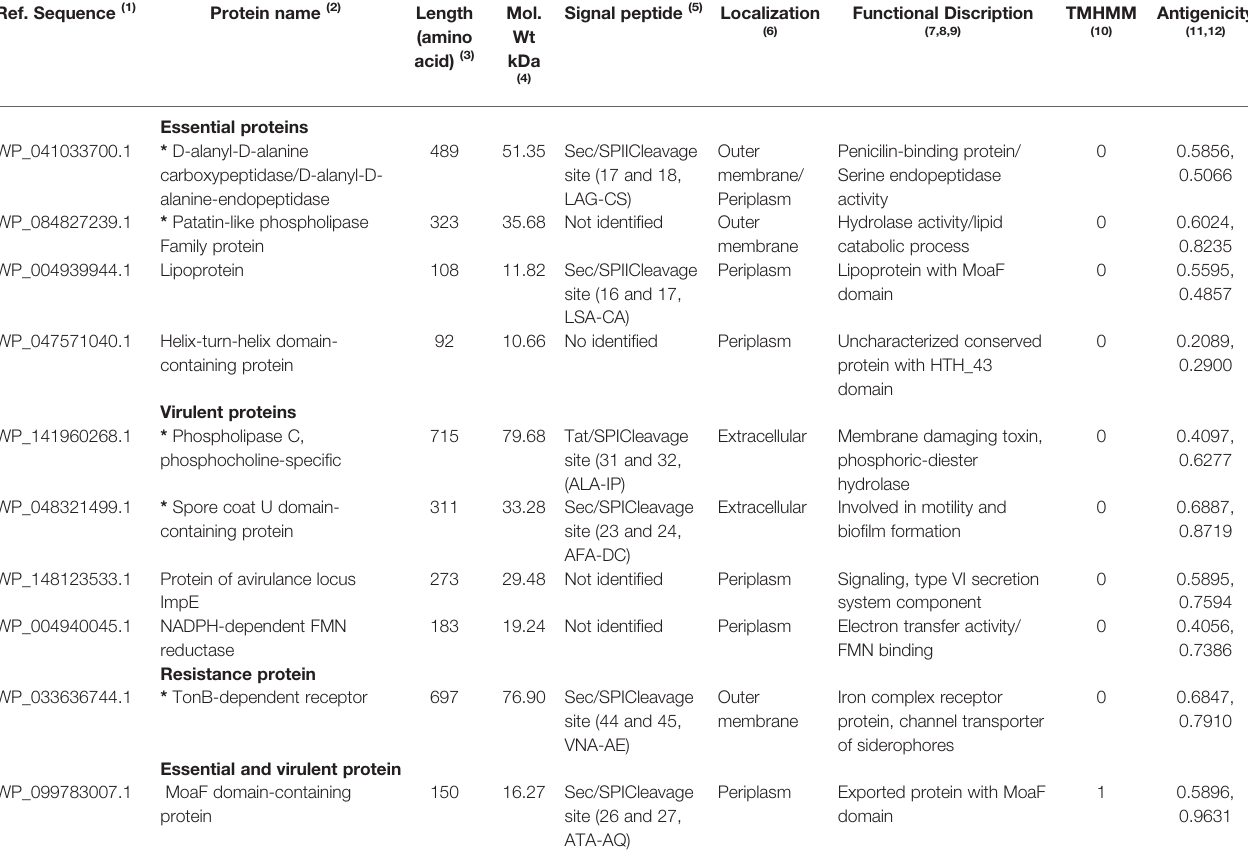
TABLE 1 | Predicted subcellular localization, physicochemical, antigenicity, trans-membrane alpha-helices and peptide signal analysis. Ref. Sequence